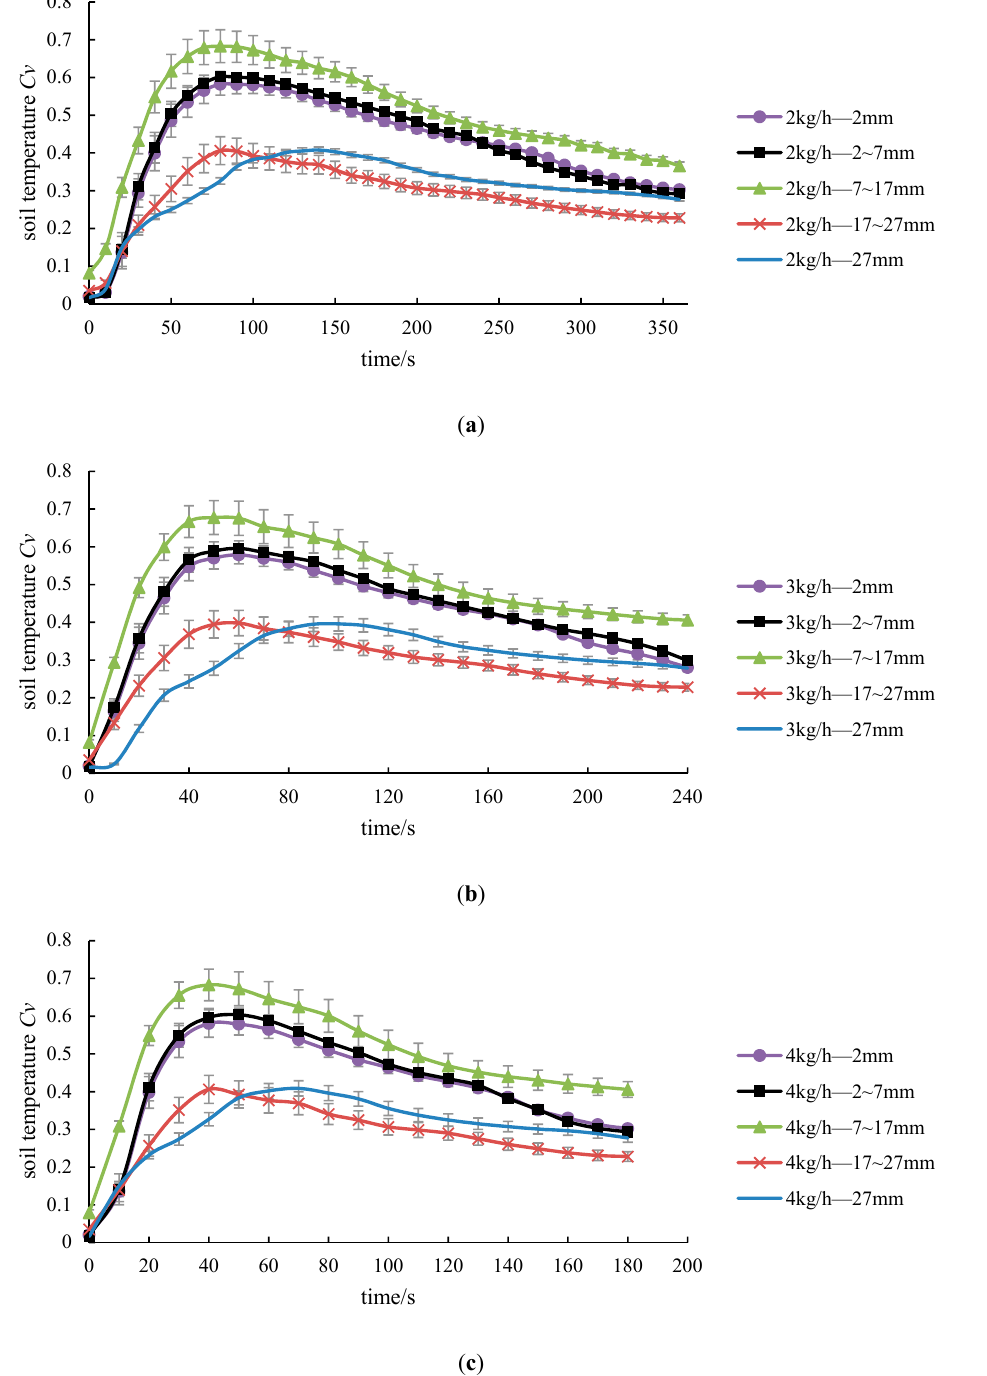
Figure 11. Variation in the mean ST variation coe ffi cient with disinfection time. ( a ) 2 kg / h; ( b ) 3 kg / h; and; ( c )4kg /